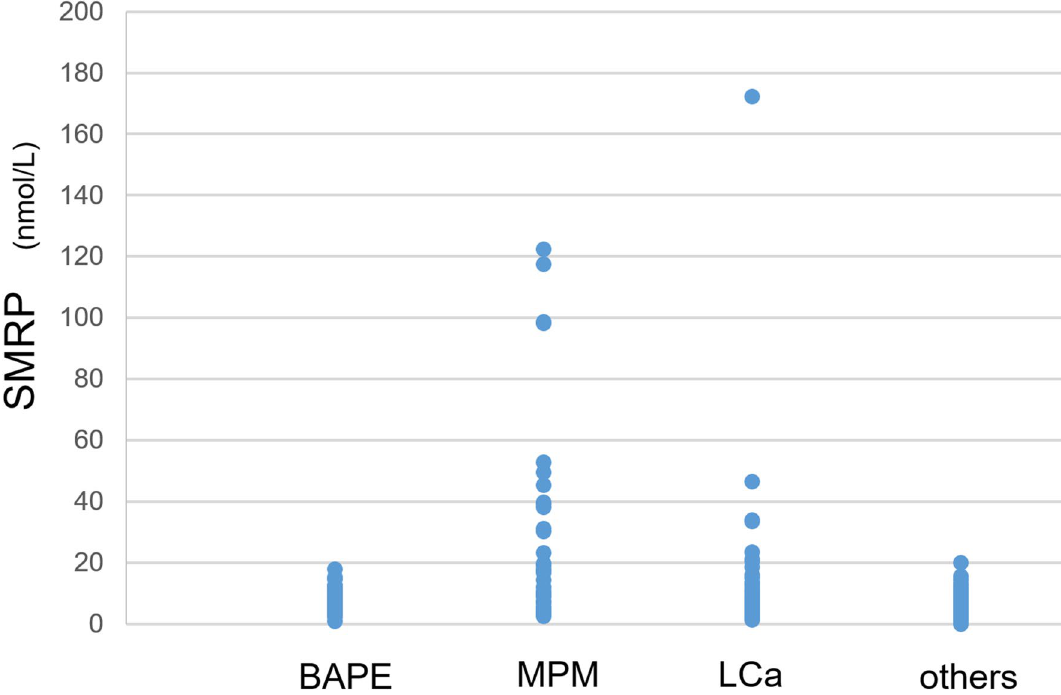
Figure 3. SMRP levels in pleural effusion from patients with BAPE, MPM, LCA, and IF. SMRP soluble mesothelin-related peptides, BAPE benign asbestos pleural effusion, MPM malignant pleural mesothelioma, LCA lung cancer, IF bacterial